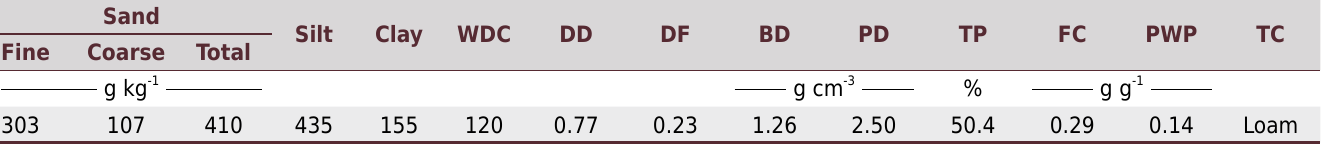
Table 2. Physical properties of the Neossolo flúvico used in the experiment Sand Silt Clay WDC DD DF BD PD TP PWP TC Fine Coarse Total g kg -1 WDC: water-dispersible clay; PD: particle density; BD: soil bulk density; DD: degree of dispersion (WDC/Clay); DF: degree of flocculation (1 - DD); TP: total porosity; TC: textural classification; FC: field capacity; PWP: permanent wilting point. Soil granulometry analysis according to Donagemma et al. (2017); WDC, DF, and DD according to Donagemma and Viana (2017); BD (Almeida et al., 2017a); PD (Viana et al., 2017). TP was estimated based on the values of the BD and PD (Almeida et al., 2017b). The FC and PWP were determined based on the soil water retention curve (SWRC) (Teixeira and Bhering,